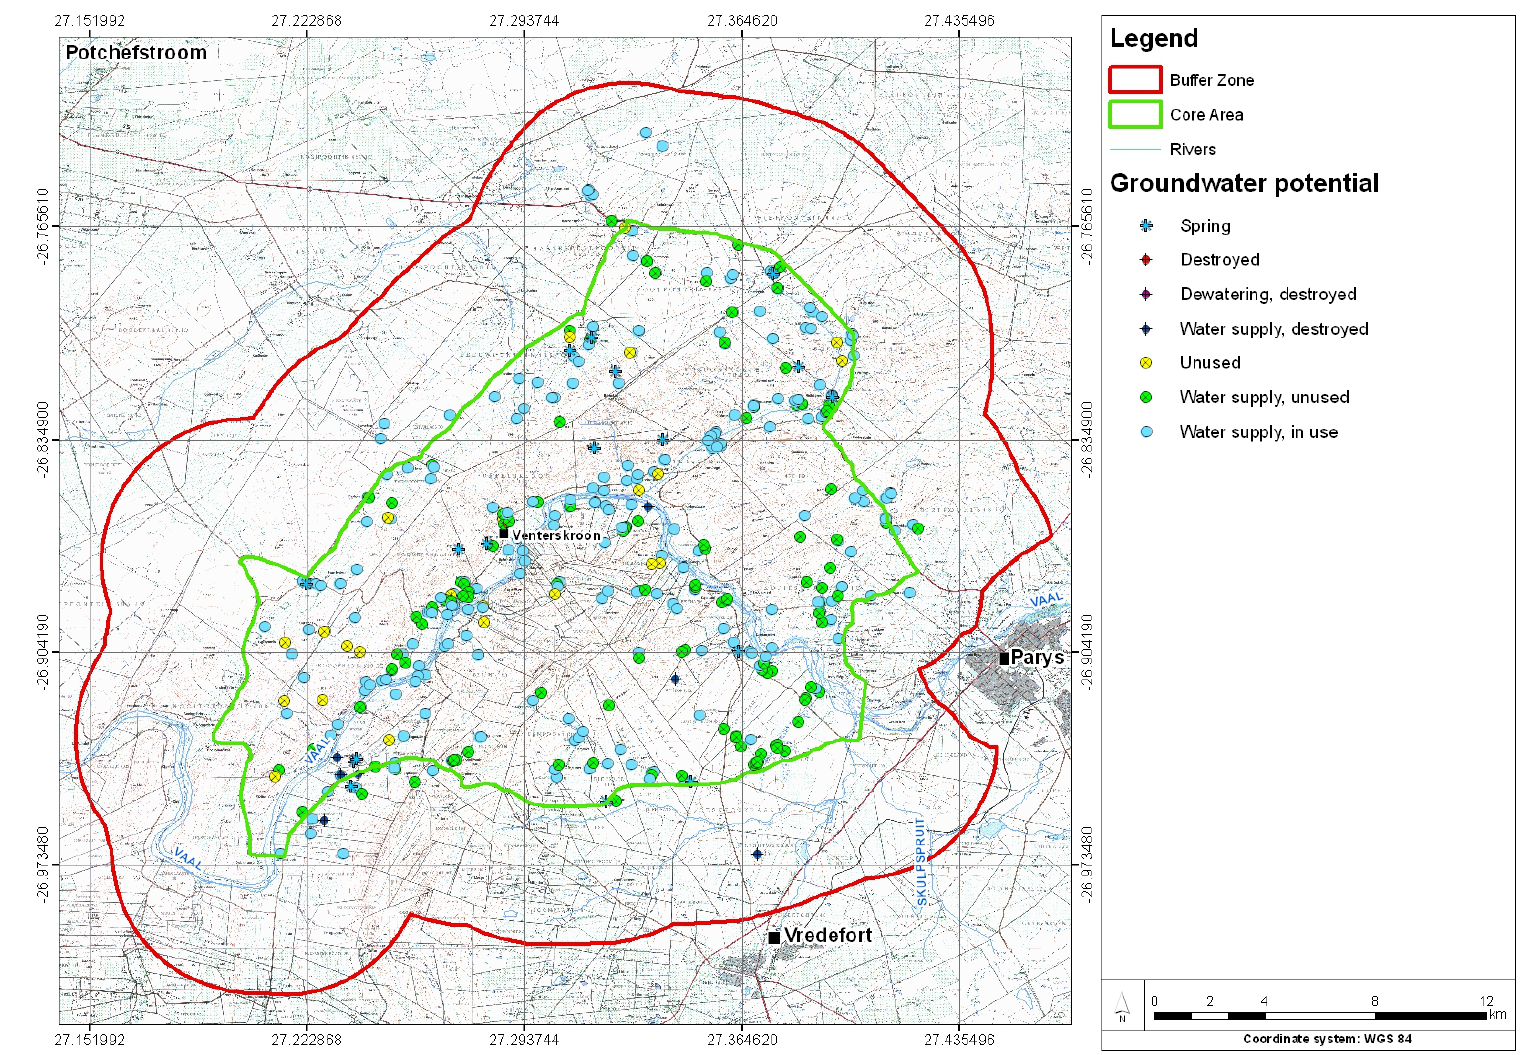
Figure 6. Borehole status in the